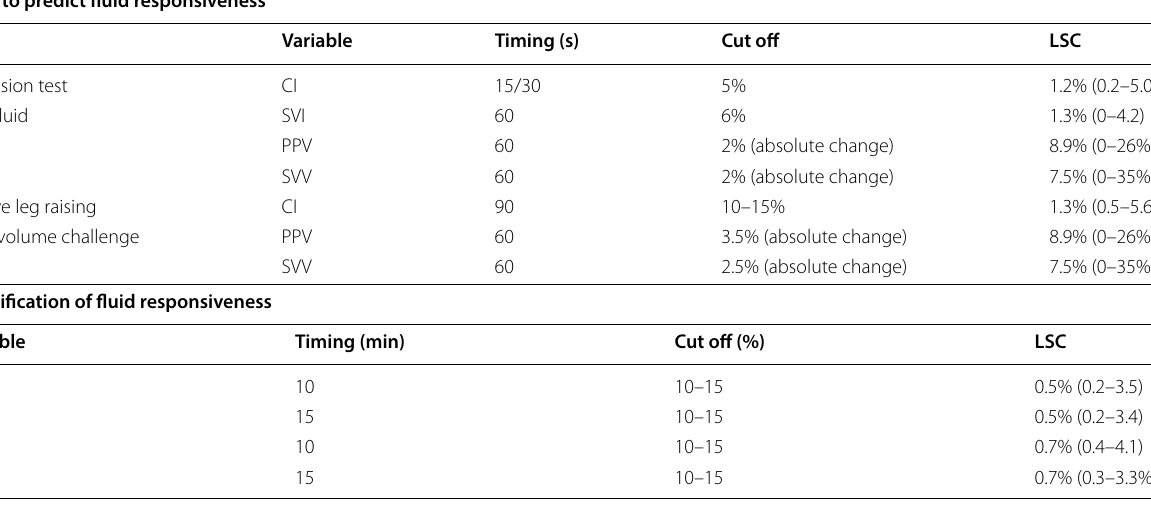
Table 3 Prediction and identification of fluid responsiveness: least significant change (LSC), timing and proposed